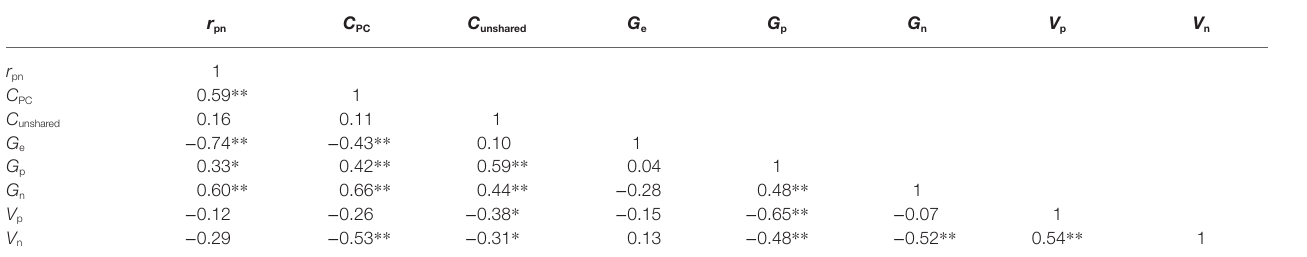
TABLE 3 | Associations between indicators of emotional complexity in Study 1. C PC C unshared